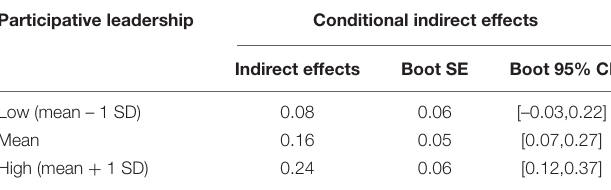
TABLE 6 | The indirect effect in different levels of participative leadership. Participative